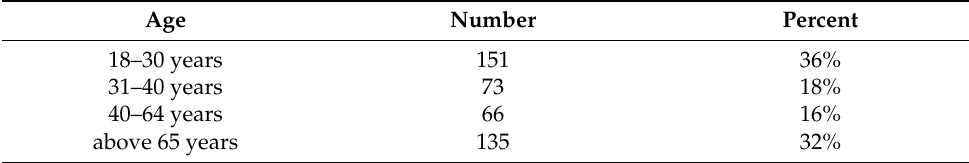
Table 3. Age structure.